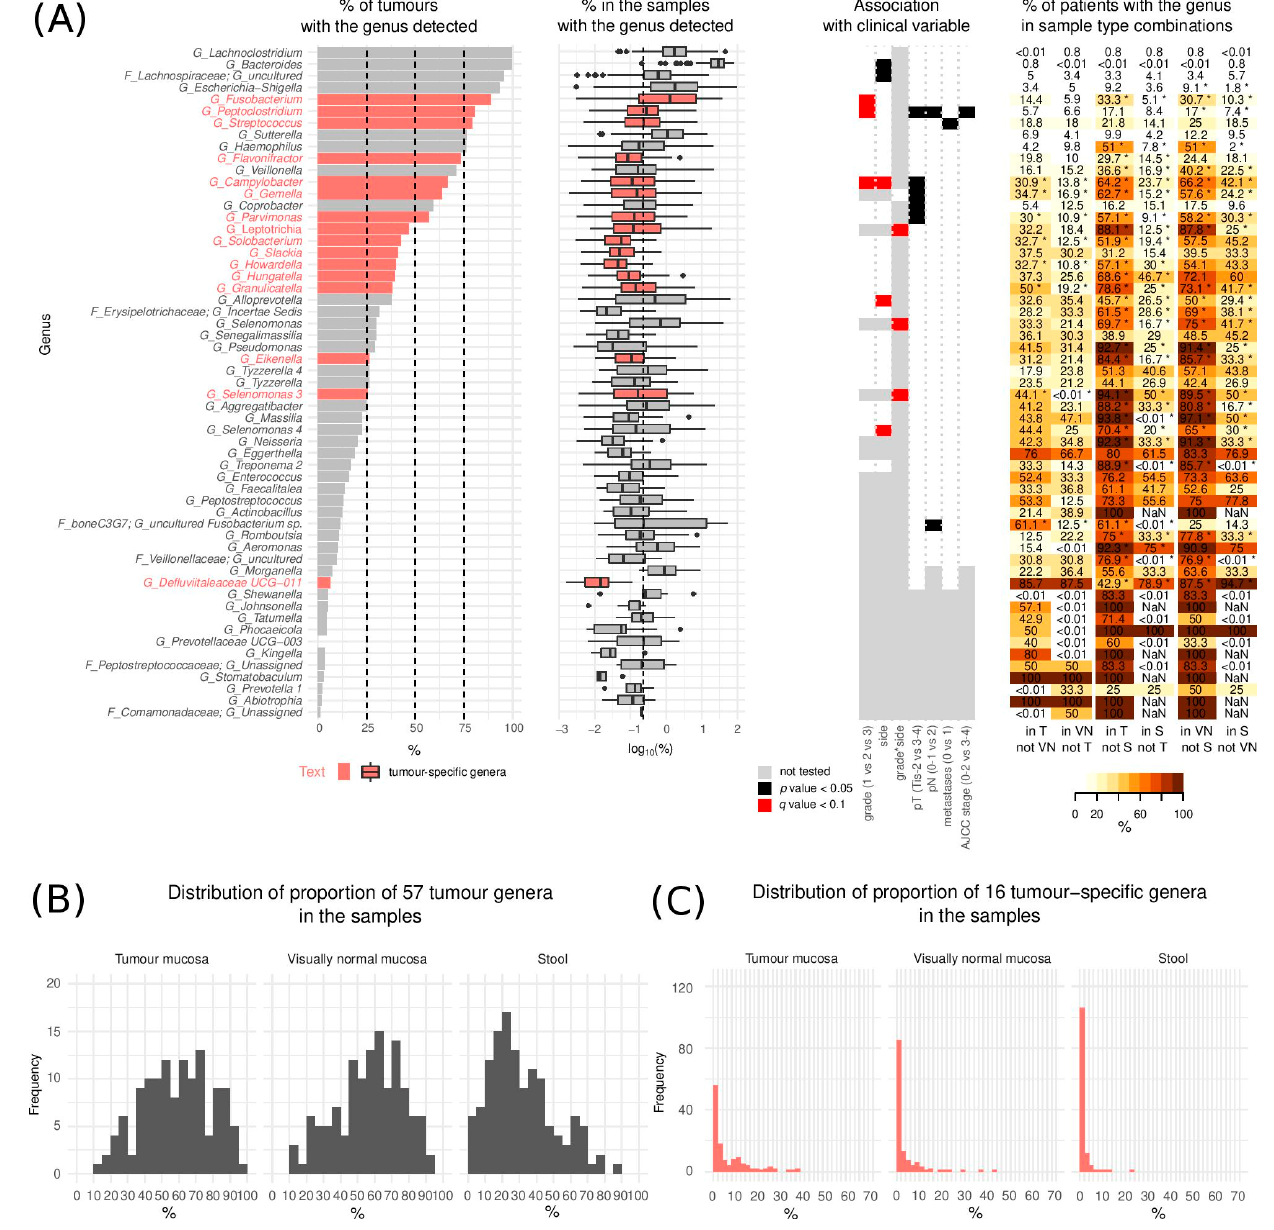
Figure 2. Tumour genera. ( A ) (left) Proportion of tumours with the genera detected and distribution of their respective relative abundances (in %) in the samples where they were detected (middle) and association of the bacteria with clinical variables (right). The vertical dashed line represents the median relative abundance of all 264 detected genera (median = 0.24%). The boxplot middle vertical line represents median, the box represents the interquartile range (IQR), the whiskers extend to +/-1.5 IQR. The black dots refer to outliers. ( B ) Overall proportion of the 57 tumour genera in the three sample types ( n = 127) ( C ) Overall proportion of the 16 tumour-specific genera in the three sample types ( n = 127). (Tis-Tumour in situ, pT-tumour pathologic stage, pN-regional lynph nodes pathologic, T-tumour swabs, VN-visually normal mucosa swabs, S-stool, NaN-not a number). * p < 0.05.